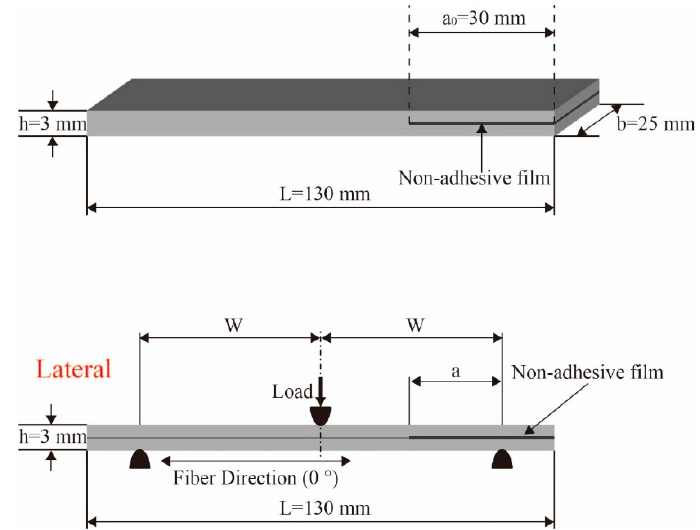
Figure 12. Dimensions and schematic of laminate specimen and the end notched flexure (ENF) test (dimensions are in mm).